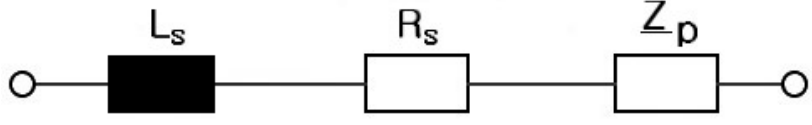
Figure 10. Electrical equivalent circuit of the supercapacitor [6].